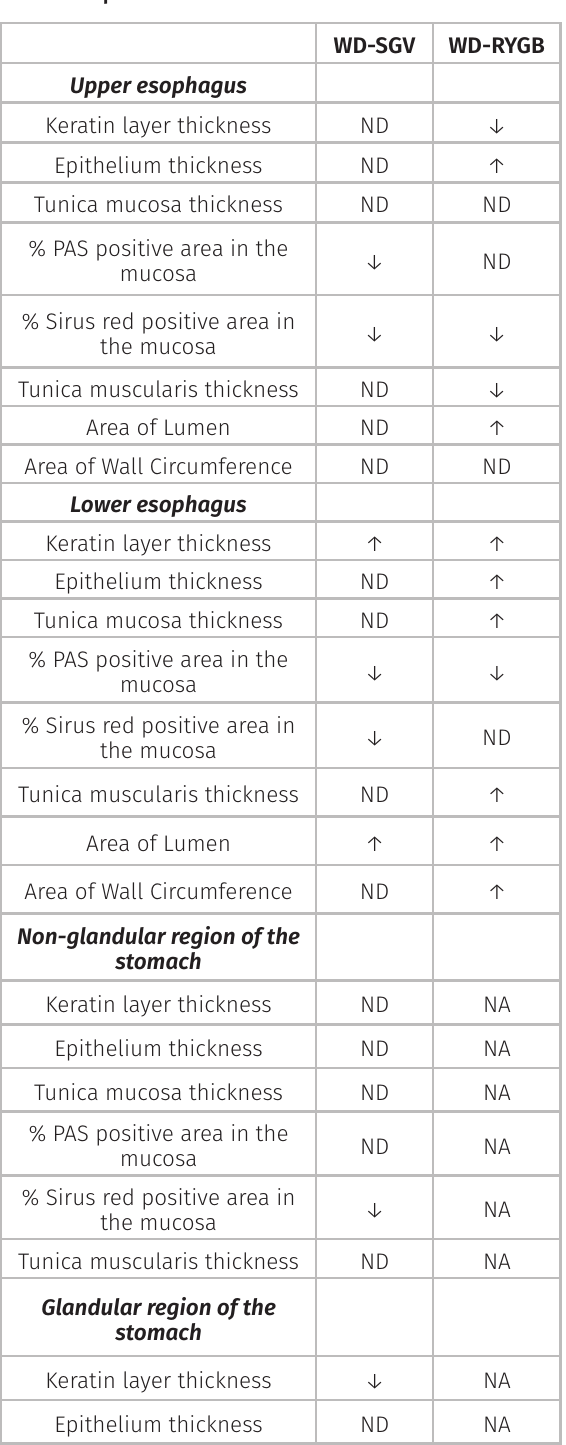
Table I. Sum up of morphological alterations in gastrointestinal organs of WD-SGV or WD-RYGB rats, when compared to WD-SHAM